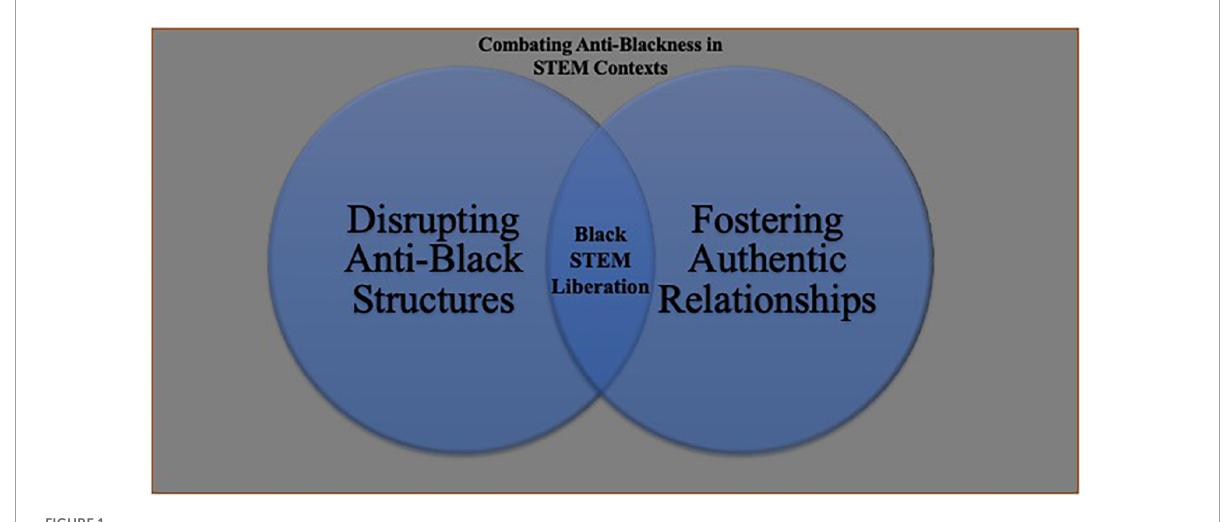
FIGURE1 Conceptual model for combatting anti-blackness in STEM